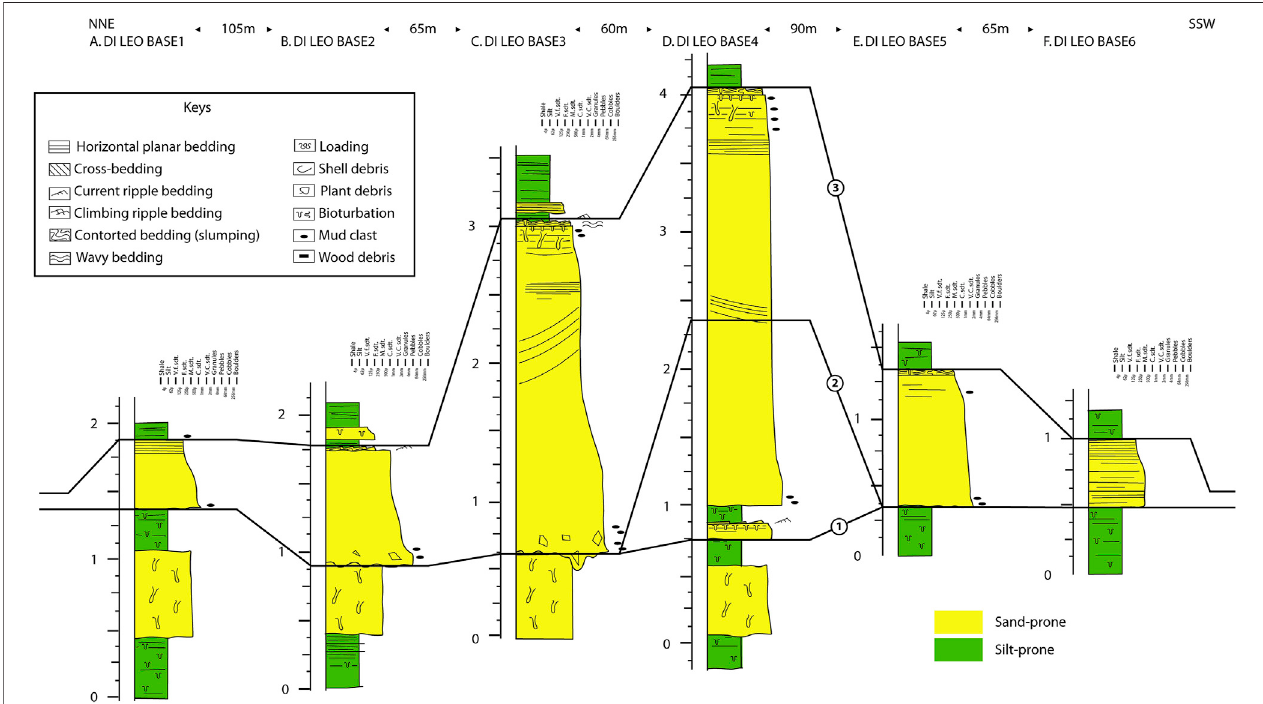
FIGURE 12 | Correlation panel of the Di Leo area illustrating an isolated detached lobe. Surface 1 is erosive in the proximal area (NNE) and progressively conformable in the most distal area (SSW). Rapid progradation is illustrated between surfaces 1 and 2. Prograding to aggrading trend is illustrated between surfaces 2 and